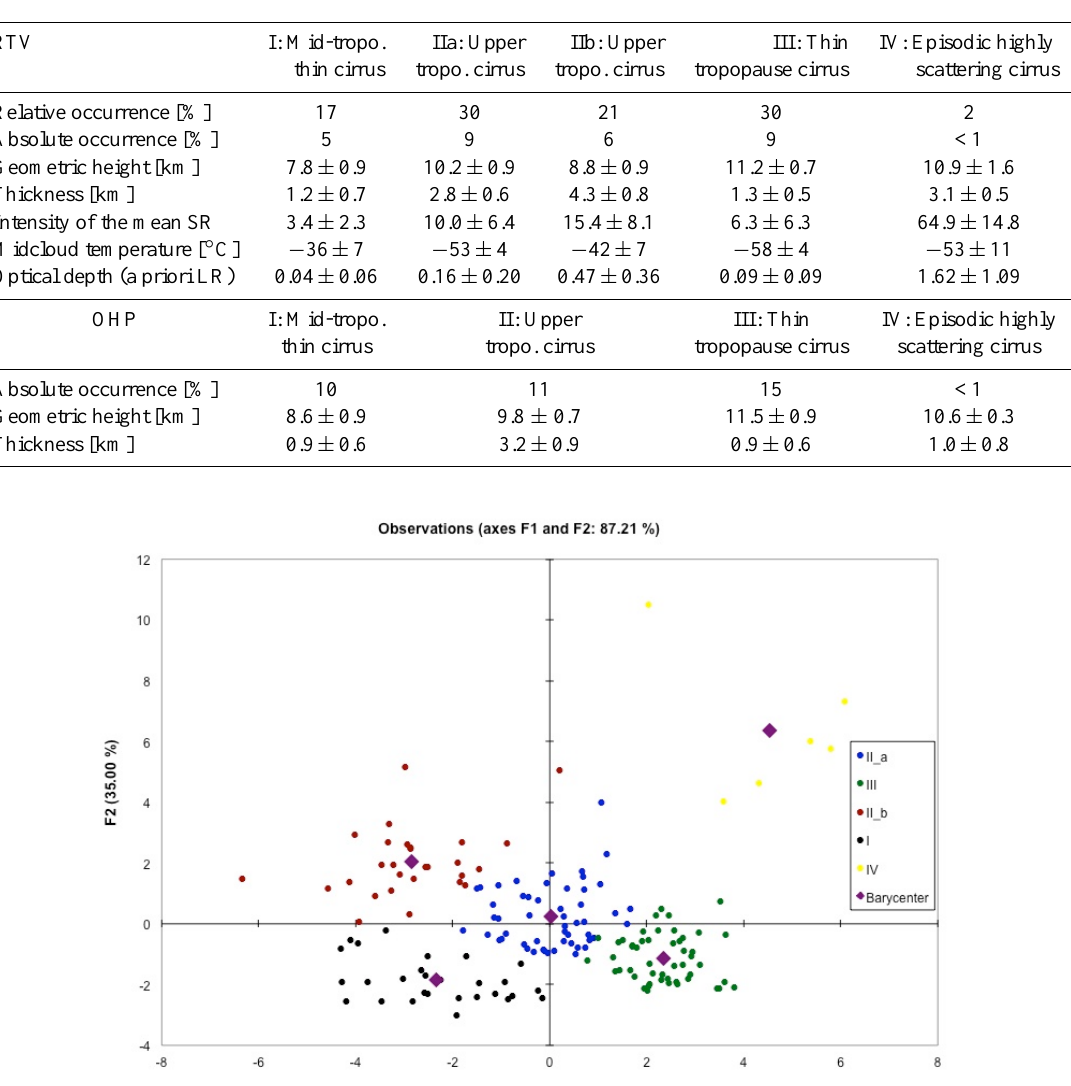
Table 3. Principal lidar parameters of the cirrus classes identified by multivariate analysis applied to the RTV data set (2007–2010). Temper- ature values are derived from the operational radiosonde launched from Pratica di Mare (25km southwest of RTV). In the bottom part of the table, the lidar parameters of the cirrus classes identified at OHP by the same analysis are listed.